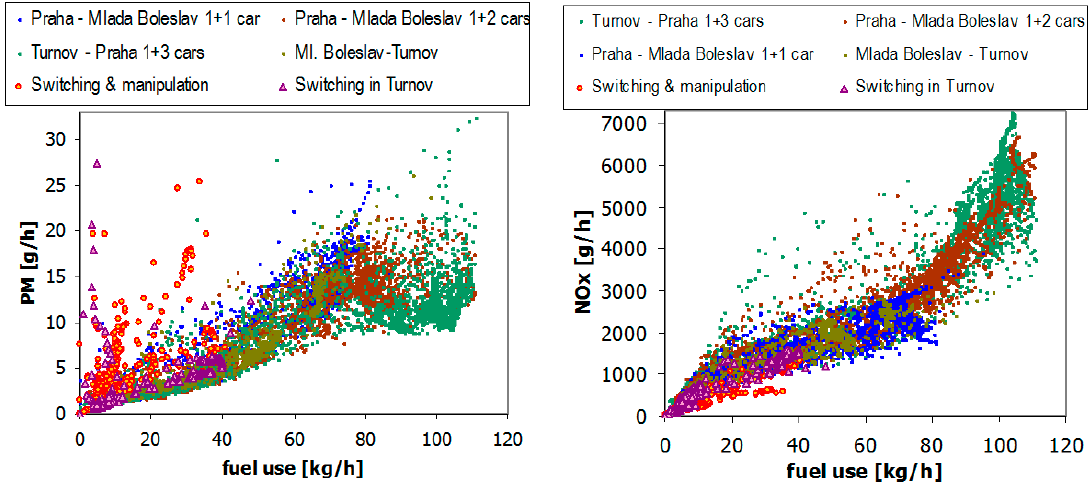
Figure 14. Emission rates from an 854 series railcar: ( a ) particulate matter; and ( b ) nitrogen oxides.